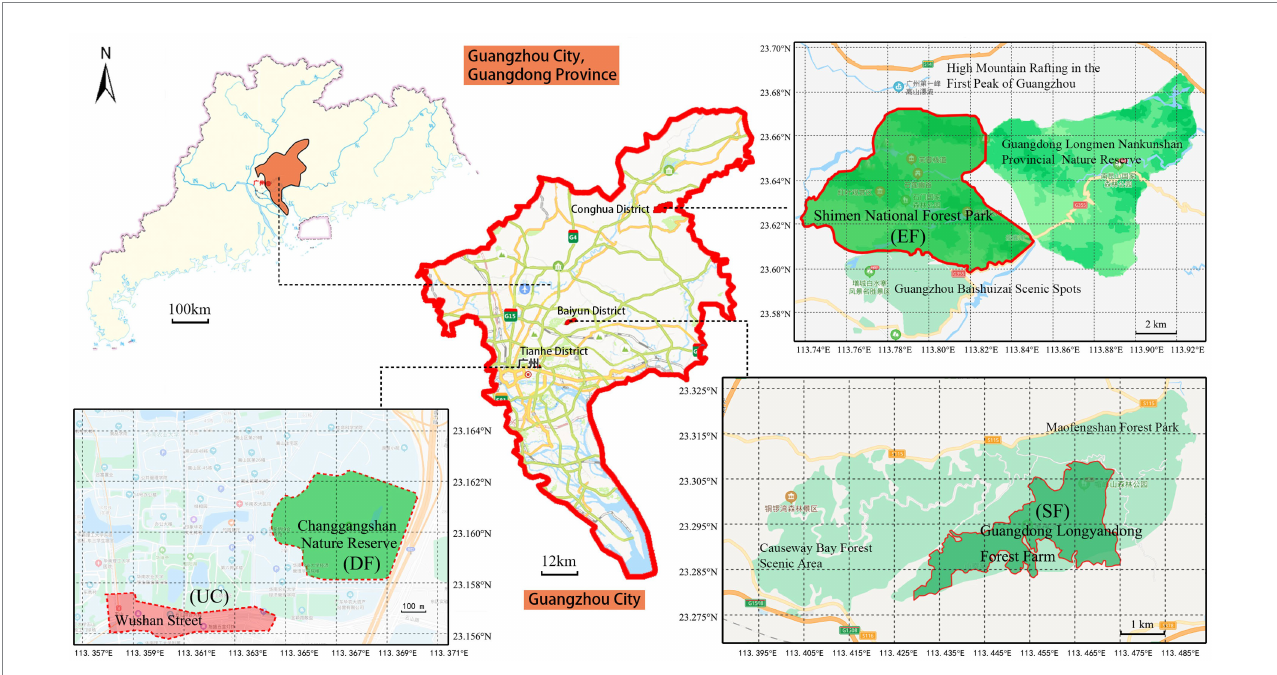
FIGURE 1 Location of study area selection of urban forests in different geographical